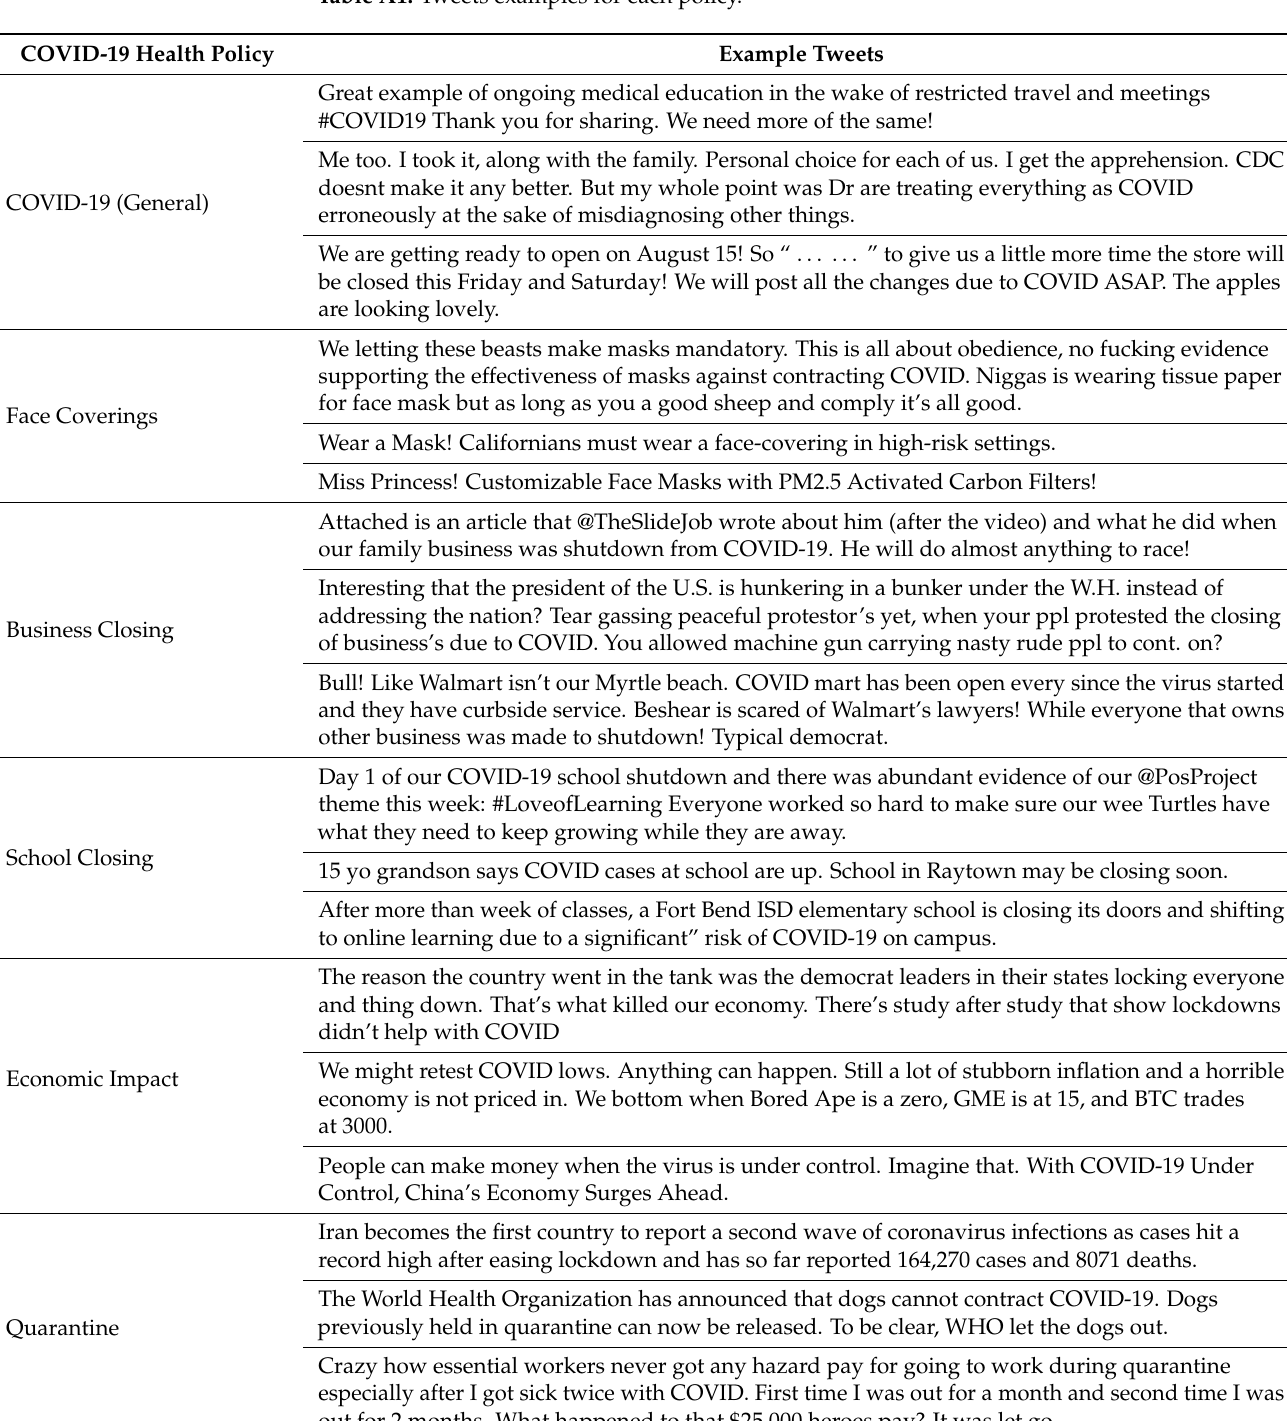
Table A1. Tweets examples for each